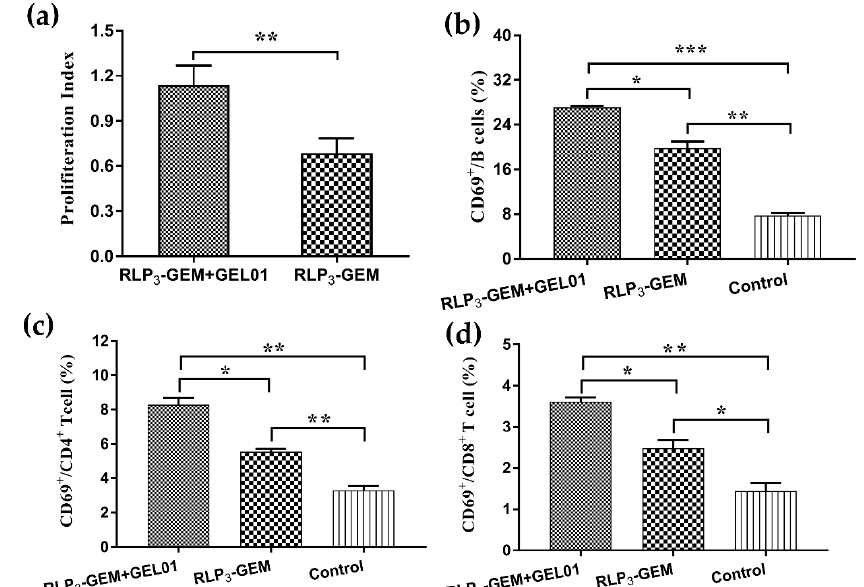
Figure 5. Index of lymphocytes and activated (CD69 + ) B cells, CD4 + and CD8 + T cells harvested from the spleen. At 7 days after the last immunization, lymphocytes from mice immunized intranasally were harvested and re-stimulated with RBD (10 µg/mL) in vitro. The proliferative index of the spleen was detected using a CCK-8 assay. The frequency of CD69 + CD19 + B cells, CD69 + CD4 + T cells and CD69 + CD8 + T cells was estimated by flow cytometry. Data in ( a ), ( b ), ( c ), and ( d ) are expressed as the mean ± SD for each group. * p < 0.05; ** p < 0.01; *** p < 0.001.